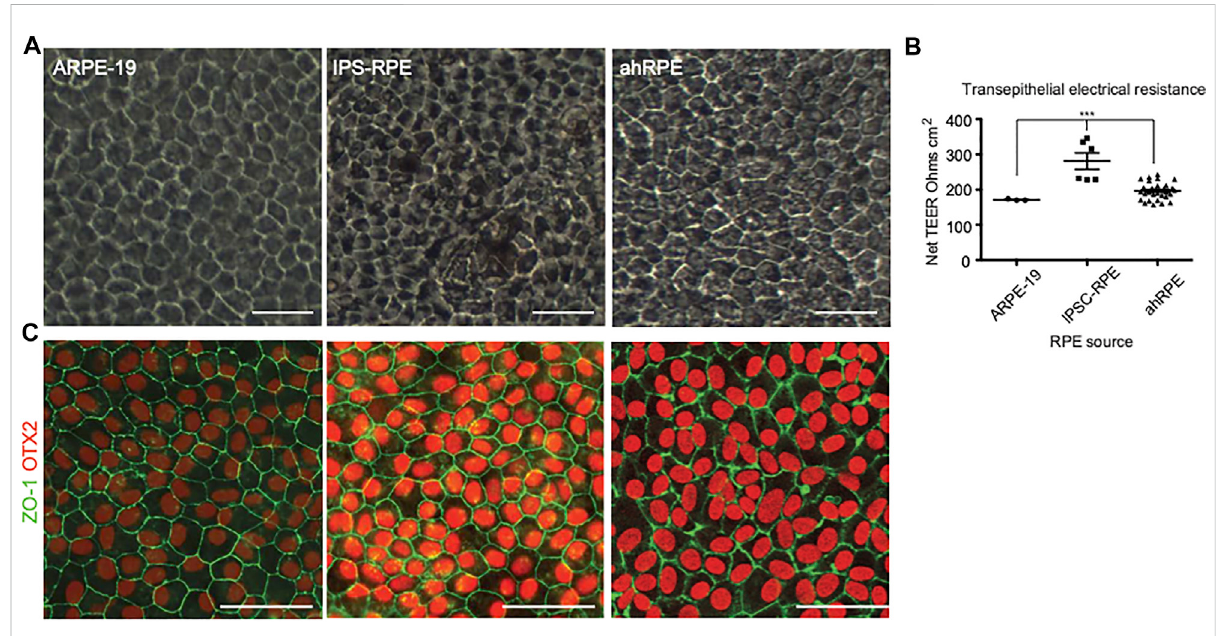
FIGURE 1 Phenotypic comparison between different sources of RPE. (A) Phase images of RPE after 1 month in culture. (B) Sentinel cultures of RPE plated in A were also plated in transwells, and TEER was measured after 1 month in culture. (C) Immuno fl uorescence of RPE from the different sources stained with antibodies to RPE markers OTX2 and ZO-1. *** indicates p -value is > 0.0001. Scale bar = 50 μ